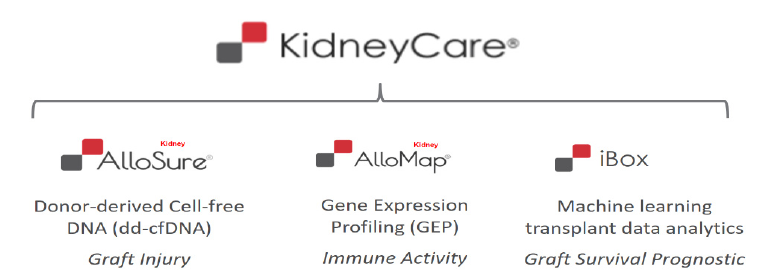
Figure 1. Multimodality testing using dd-cfDNA, GEP and machine learning to better assess organ health and enable the optimization of immunosuppression.